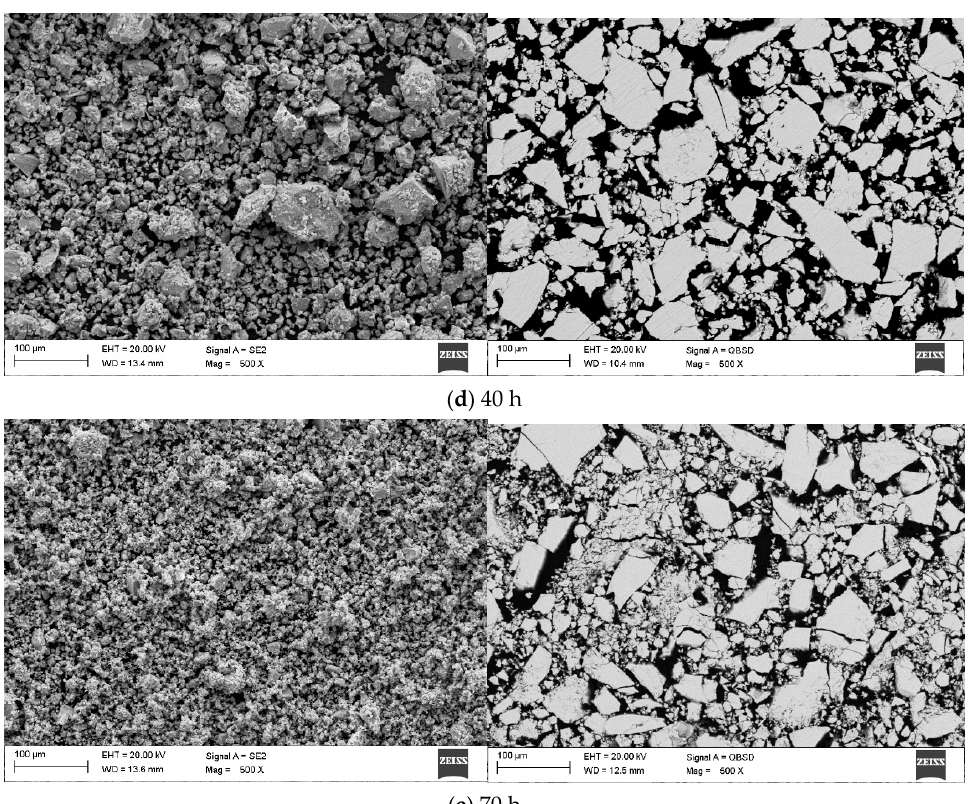
Figure 5. SEM (scanning electron microscopy) results - Morphology with the micrographs of the Mg 65 Zn 30 Ca 4 Gd 1 alloy powder samples milled for ( a ) 13; ( b ) 20; ( c ) 30; ( d ) 40; ( e ) 70 h, respectively. Table 3. EDS (energy-dispersive spectroscopy) results from the Mg 65 Zn 30 Ca 4 Gd 1 powder alloy samples for 13, 20, 30, 40, and 70 h, respectively.